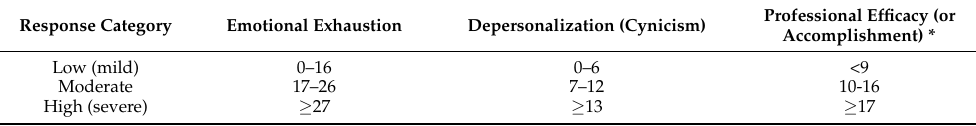
Table 1. Response categories on Maslach Burnout Inventory Survey (MBI-GS). Response